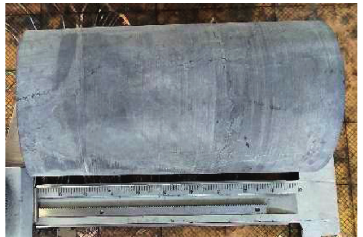
Figure 1: Mudstone test